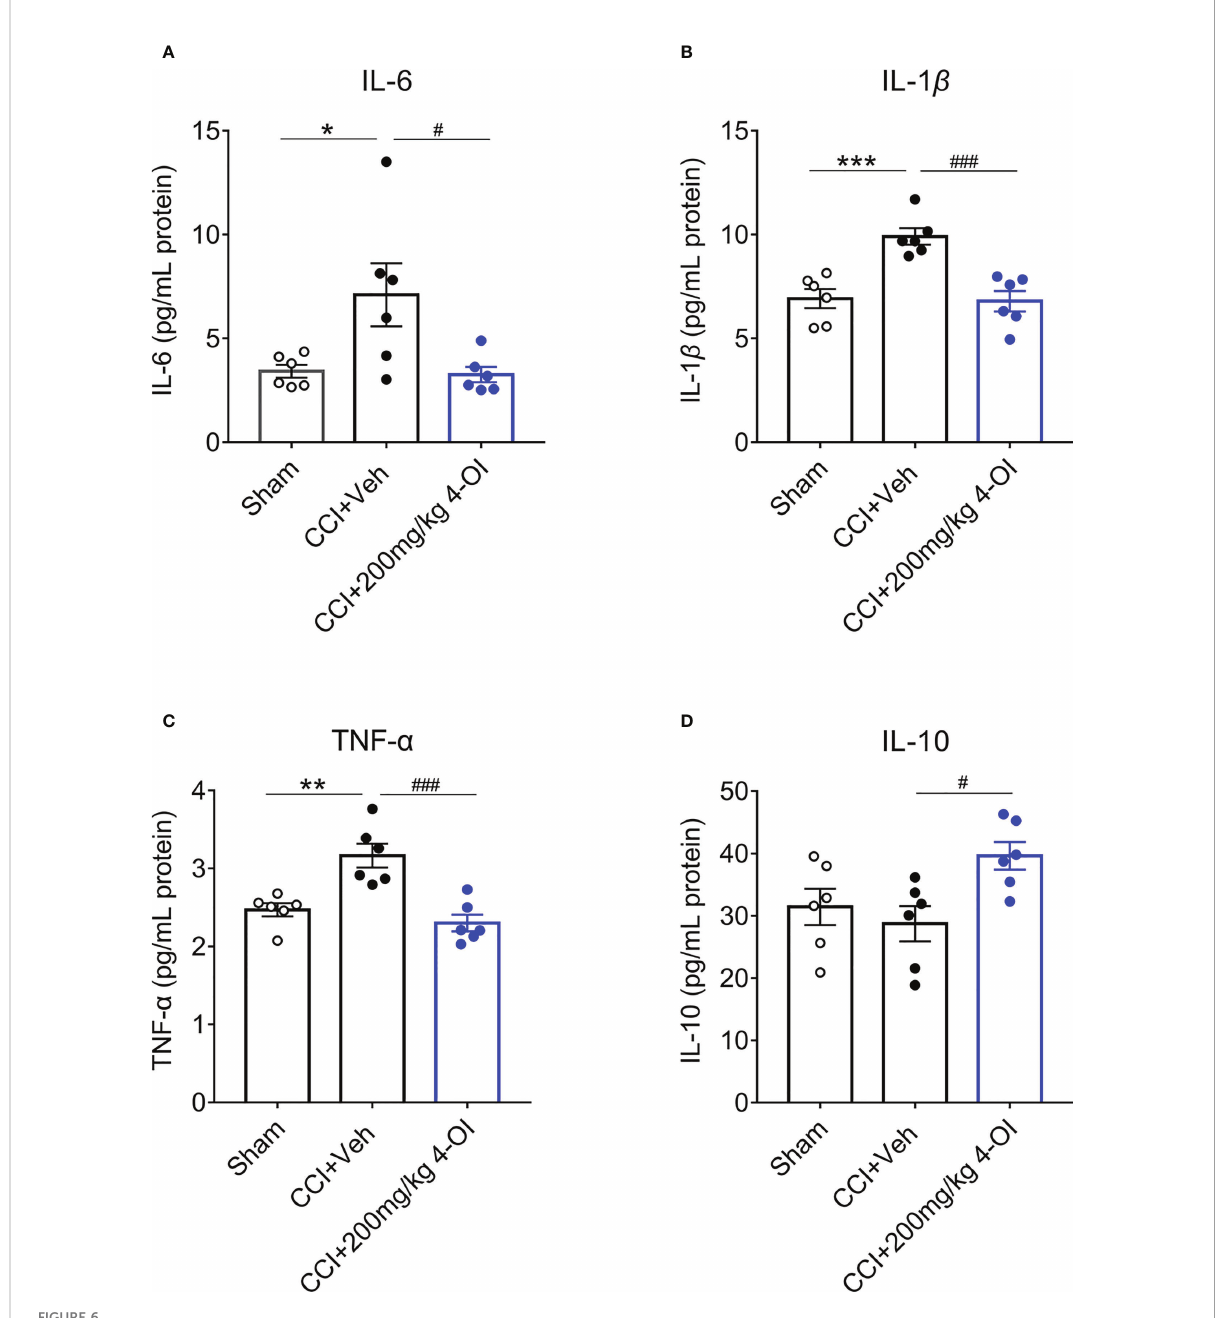
FIGURE 6 4-OI affected the spinal content of cytokine in CCI model. The expressions of in fl ammatory mediators IL-6 (A) , TNF- a (B) and IL-1 b (C) signi fi cantly increased in the ipsilateral spinal cord of CCI group at 14th days post nerve injury. At 2 hours post systemic injection of 200 mg/kg 4-OI, the expressions of IL-6 (A) , TNF- a (B) and IL-1 b (C) were markedly downregulated as well as the expression of IL-10 was upregulated (D) . Data are presented as mean ± SEM. *** p <0.001, ** p <0.01, * p <0.05 vs. Sham, ### p <0.001, # p <0.05 vs. CCI + Veh, followed by One-way ANOVA with Dunnett ’ s multiple comparisons test (n =